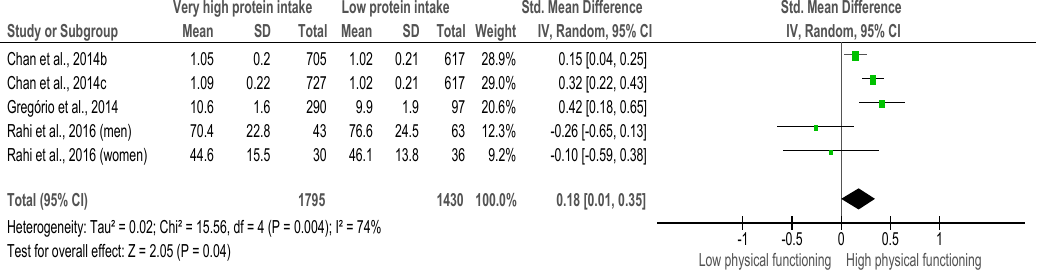
Figure 5. Standardized mean difference in Lower-limb muscle functioning according to protein intake. Squares represent study-specific estimates; diamonds represent pooled estimates of random-effects meta-analyses.